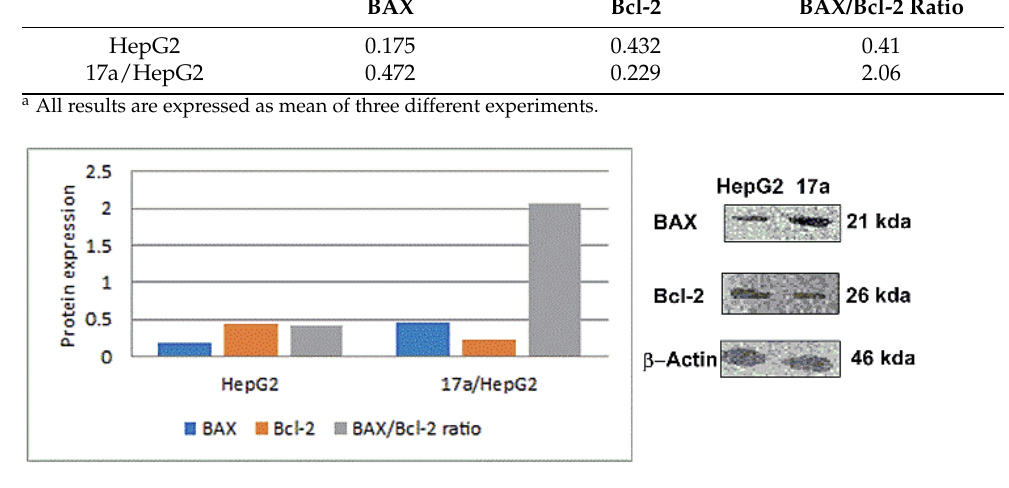
Figure 7. Effect of compound 17a on the immunoblotting of BAX and Bcl-2 proteins (normalized to β -actin).